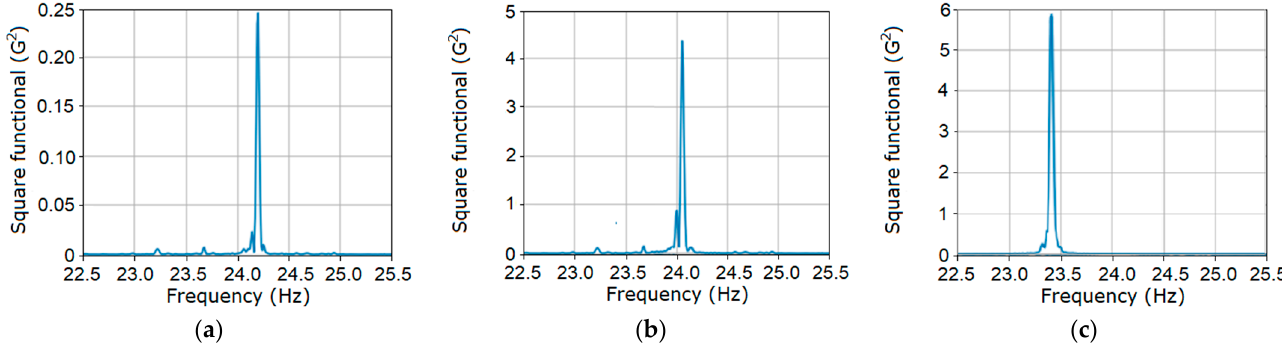
Figure 6. The dependence of the square functional of the first order on the test frequency for the first ( a ), the second ( b ) and the third ( c ) stages.